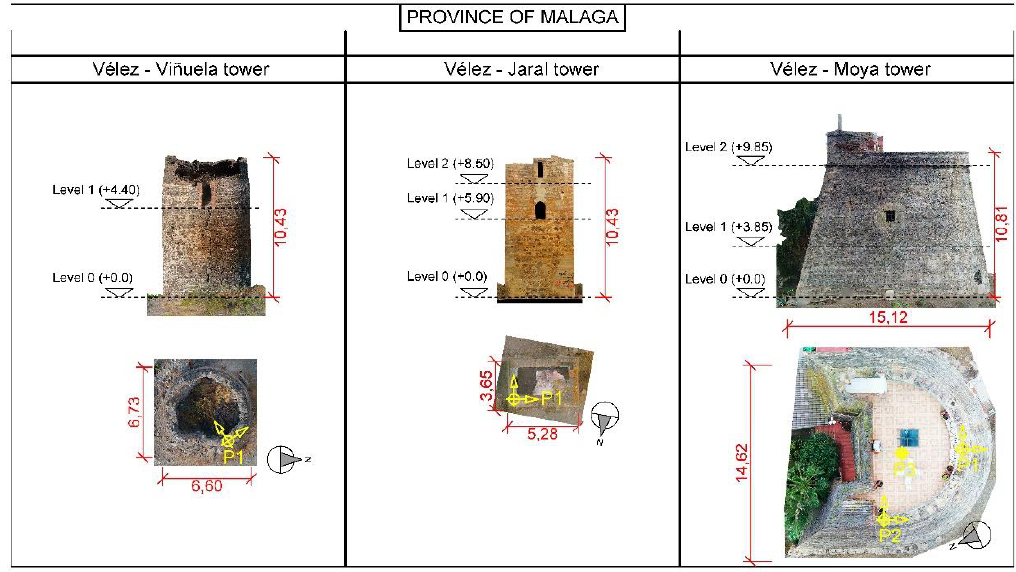
Figure 11. Points where ambient vibration testing was carried out. Towers are sorted by the provinces where they are located — Granada, Almeria and Malaga, — and by municipality.